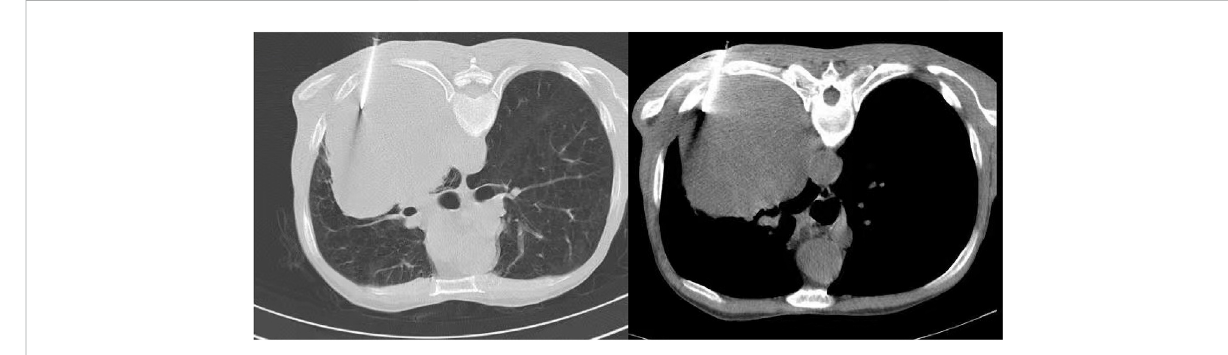
CT-guided percutaneous lung biopsy (CT-PTNB). CT = computed tomography.